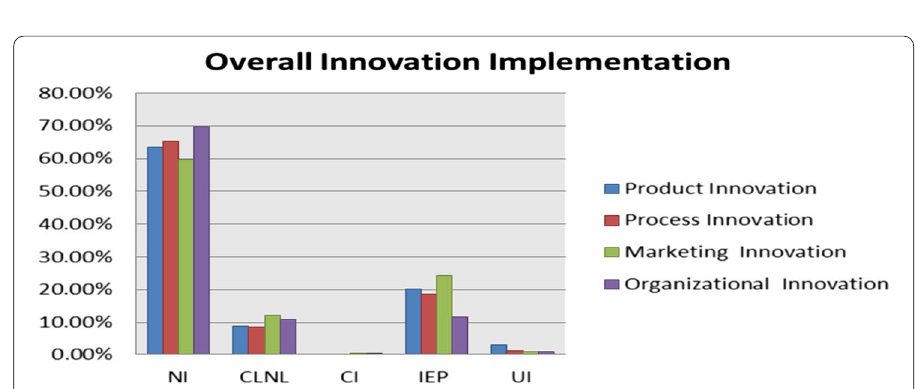
Fig. 8 Summary of innovation performance of sampled craftspeople. NI Not implemented, CLNL copied from local and national level, CI copied from international level, IEP improved from own experience